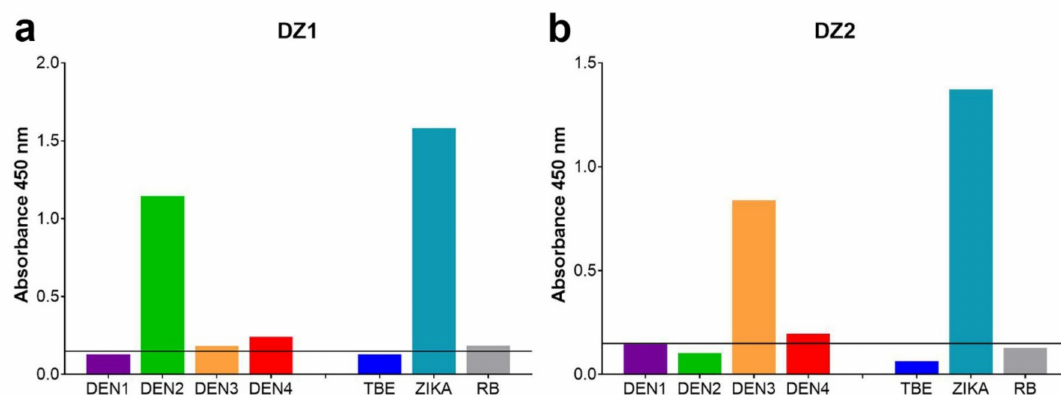
Figure 3. Flavivirus IgM E-complex ELISAs of two samples from suspected recent dengue and Zika virus infections with sEs of DEN1, DEN2, DEN3, DEN4, Zika, Rio Bravo (RB) and TBE viruses. ( a ) Sample DZ1; ( b ) sample DZ2. Solid line: cut-off.